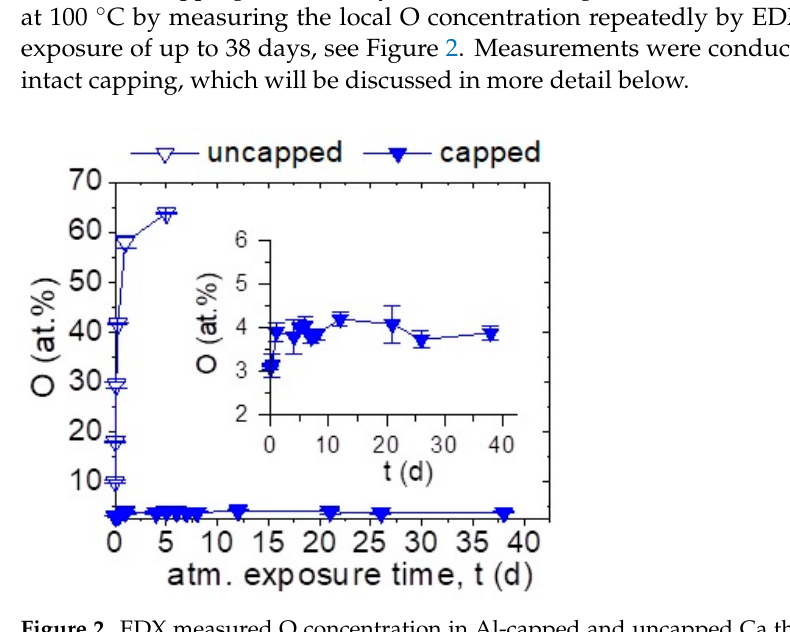
Figure 2. EDX measured O concentration in Al-capped and uncapped Ca thin films deposited at 100 °C as a function of their atmosphere exposure time after synthesis, expressed in days (d). Delami- nation occurs after 5 days of atmosphere exposure preventing further measurement of uncapped Ca. The inset shows detailed information of O concentration of capped Ca film. Al-capping layers were deposited at ≤ 50 °C.